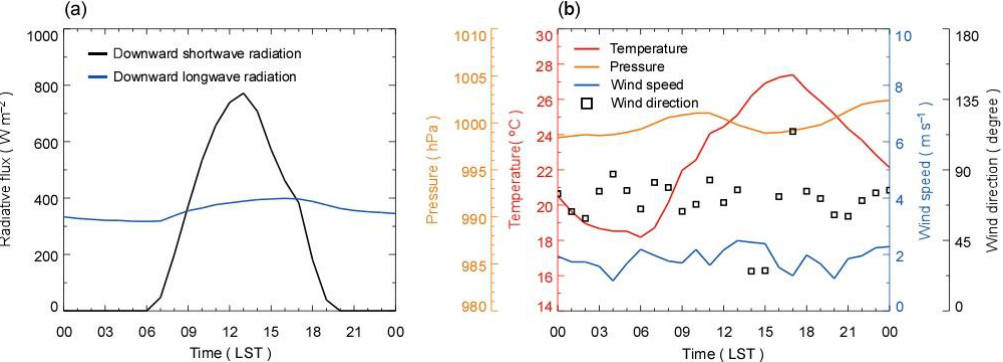
Figure 5. Diurnal variations of ( a ) downward shortwave and longwave radiation and ( b ) meteorological forcing variables on 7 September 2015.